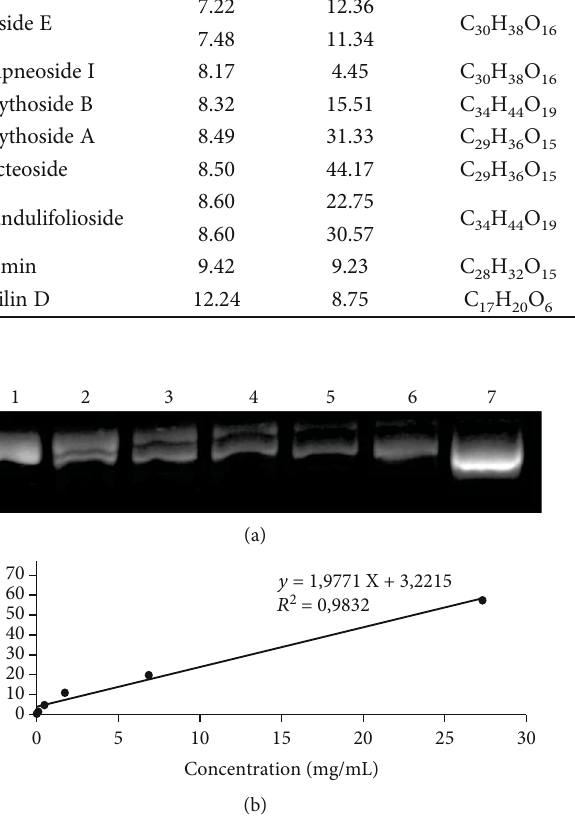
Figure 1: DNA protective e ff ect of EEPS. (a) Lane 1: DNA + H O /Fe 2+ , lanes 2 – 6: DNA + H 2 2 0.43, 1.71, 6.83, and 27.33 mg/mL), lane 7: native DNA. (b) Concentration-dependent response of protective e ff ect against DNA